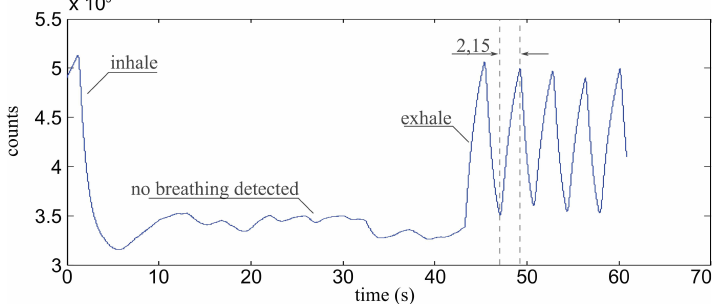
Figure 6. Sensor signal for a sensor with 5 mm bend radius showing a patient holding their breath for approximately 40 s. The autocorrelation algorithm does not detect a breathing frequency during the time the breath is